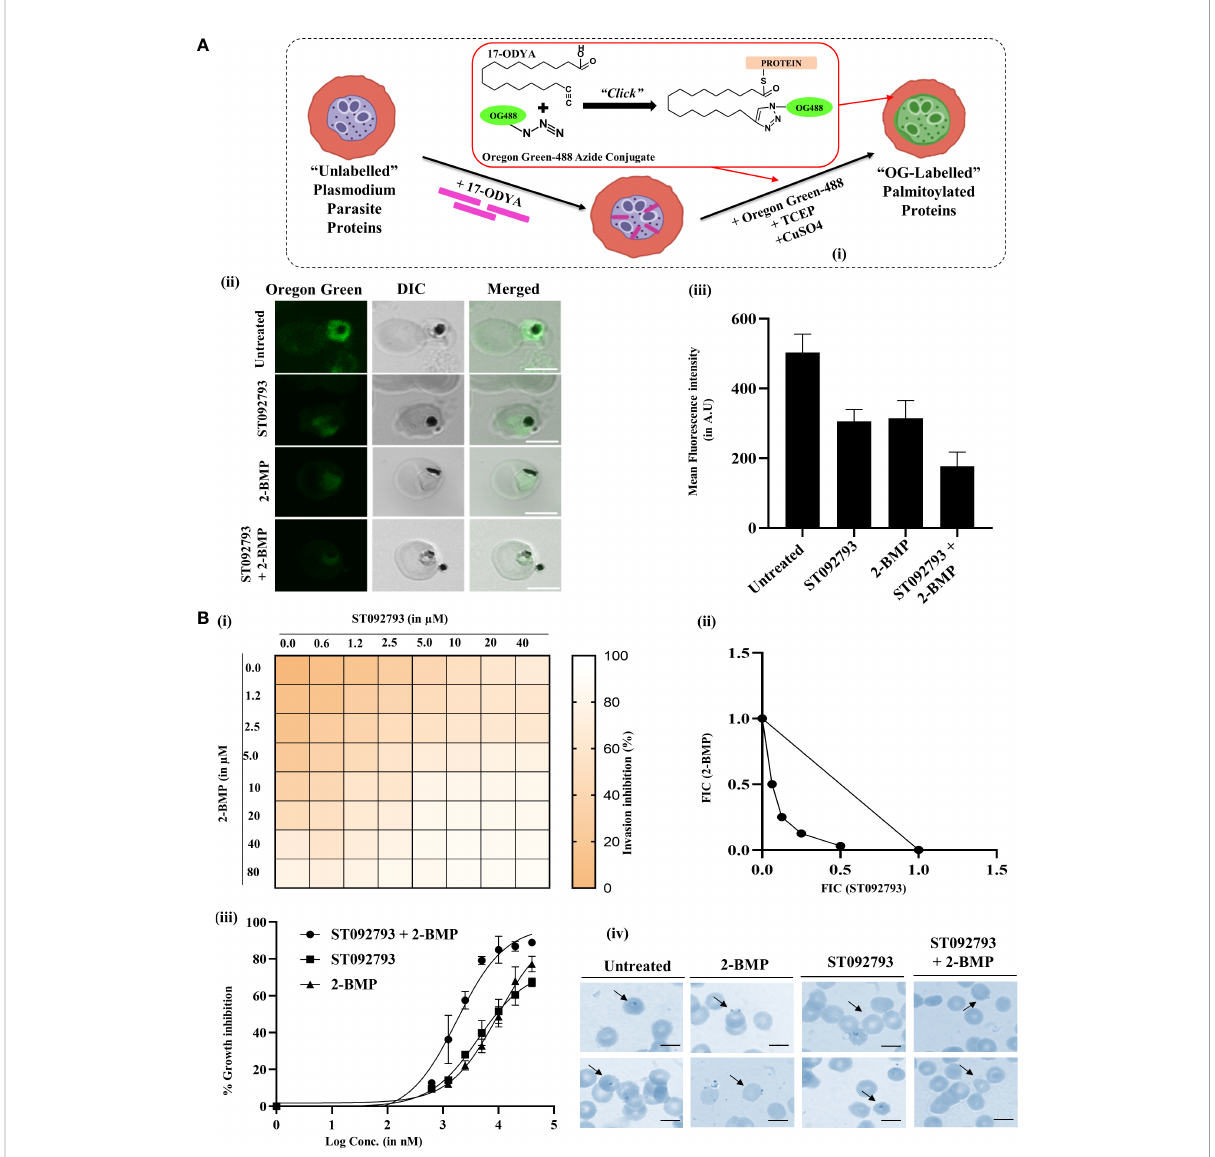
FIGURE 6 (A) (I) Schematic of the click chemistry approach for imaging in situ protein palmitoylation in malaria parasite during asexual development. Intraerythrocytic parasites were metabolically labeled with 17-ODYA (palmitic-acid analogue) followed by labeling with Oregon Green 488 in the presence of TCEP and copper sulfate. (II) Clickable metabolic labeling of the P. falciparum parasites following ST092793, 2-BMP, and ST092793+2-BMP treatment. The weak palmitoylation pro fi les in comparison to untreated parasites, especially in the case of ST092793, were observed. Scale bar indicates 5 µm. (III) Bar graphs represent the mean fl uorescence intensity (MFI) and denote the palmitoylation pro fi le in treated and untreated erythrocytes, where 20 cells were used for calculation for two biological replicates. (B) (I) The heat plot of invasion inhibition in 3D7 in the presence of ST092793 and 2-BMP when present alone and in combination (ST092793 + 2-BMP). ST092793 was added horizontally in 96-well plates (0, 0.6, 1.2, 2.5, 5.0, 10, 20, 40 µM) while 2-BMP was added vertically (0, 0.6, 1.2, 2.5, 5.0, 10, 20, 40, 80 µM) in 8*8 format. Dose – response matrices from 0% to 100% indicate different percentages of invasion inhibition. (II) The isobologram analysis of 2-BMP and ST092793 which shows a synergistic effect when used in combination against the 3D7 strain of P. falciparum with FIC index of <1. (III) The dose – response curve for 2-BMP and ST092793 when used alone and in combination. (IV) Giemsa-stained smears from 2-BMP-, ST092793-, and 2BMP+ST092793-treated parasites. Arrowhead indicates the ring formation after successful invasion, while invasion defect was observed in the case of 2-BMP-, ST092793-, and 2BMP + ST092793-treated